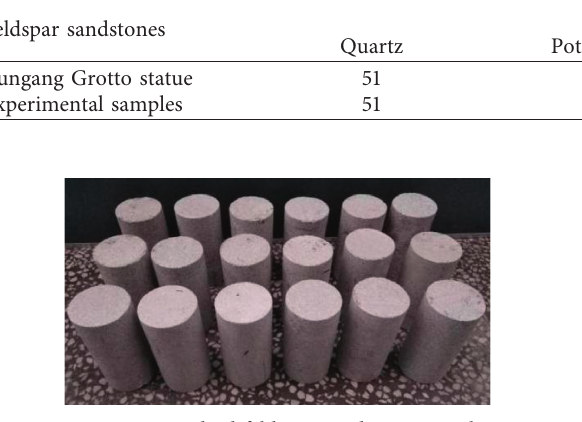
Figure 2: Standard feldspar sandstone samples.